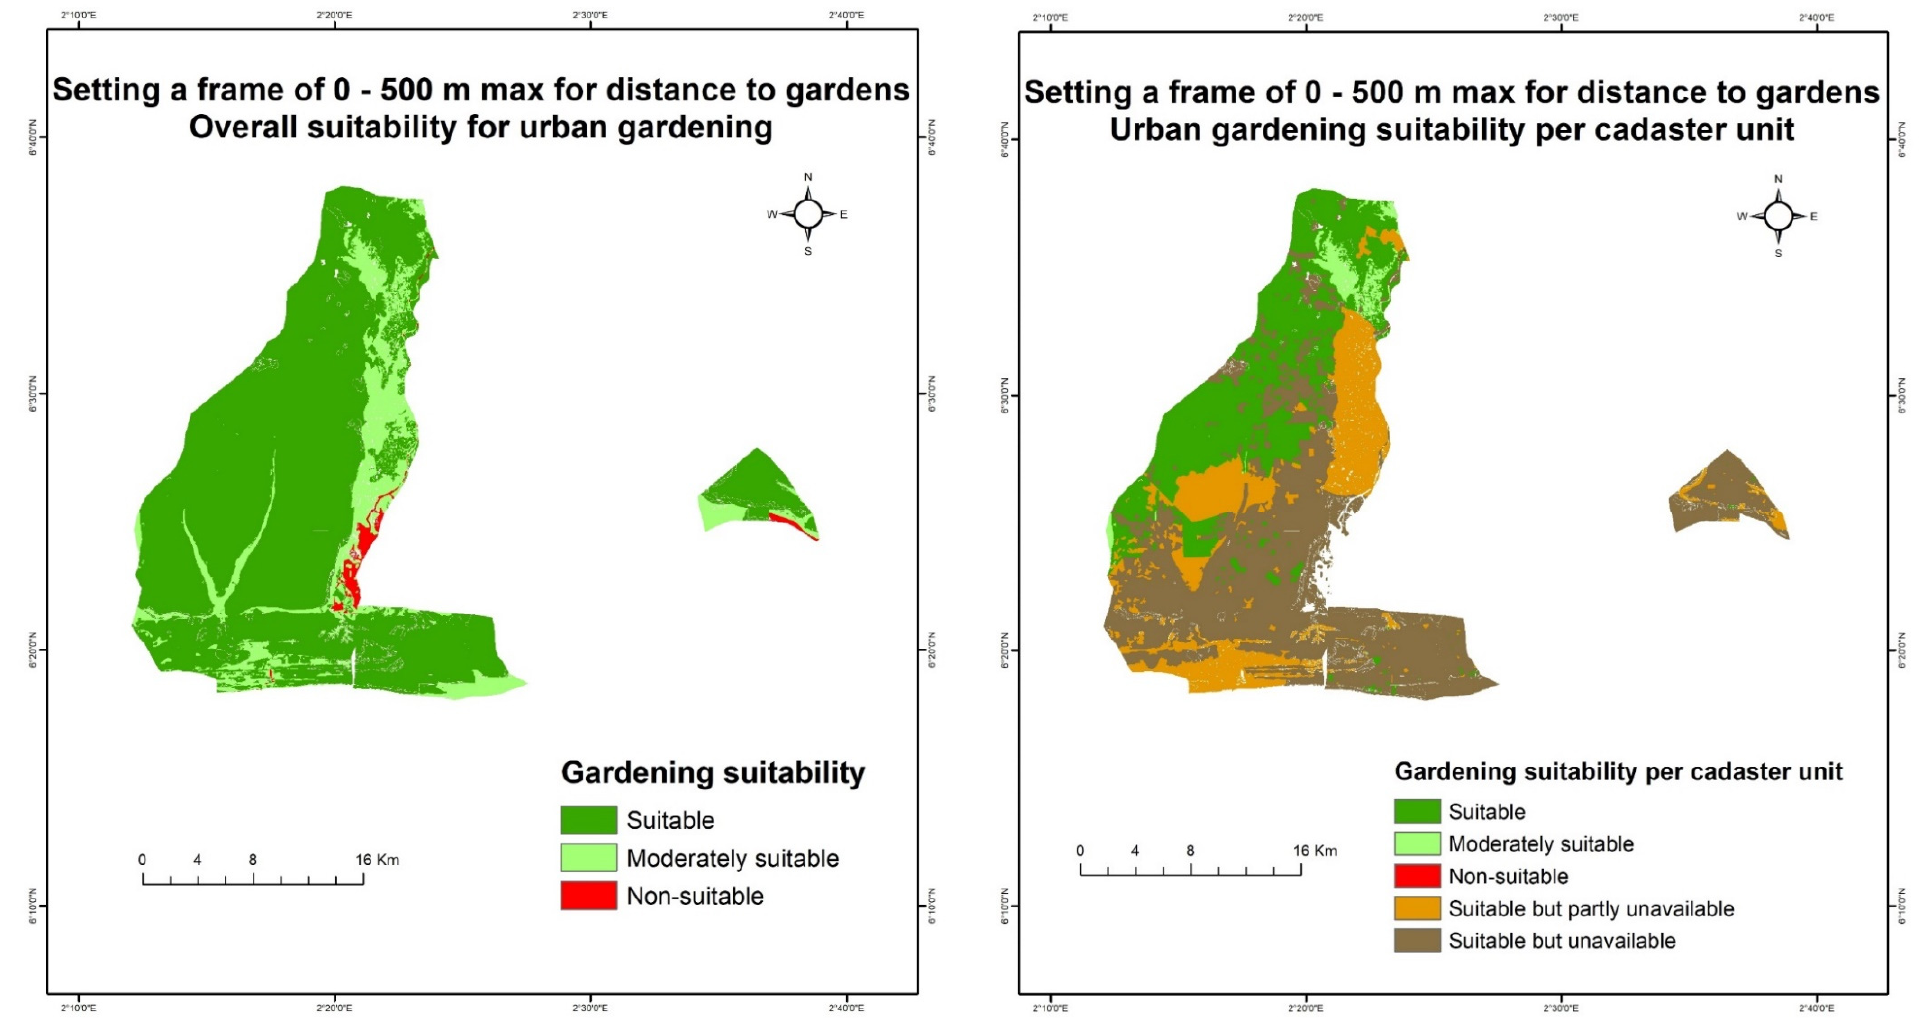
Figure 6. Classified maps of suitable areas for urban gardening: second safety improvement scenario. 2